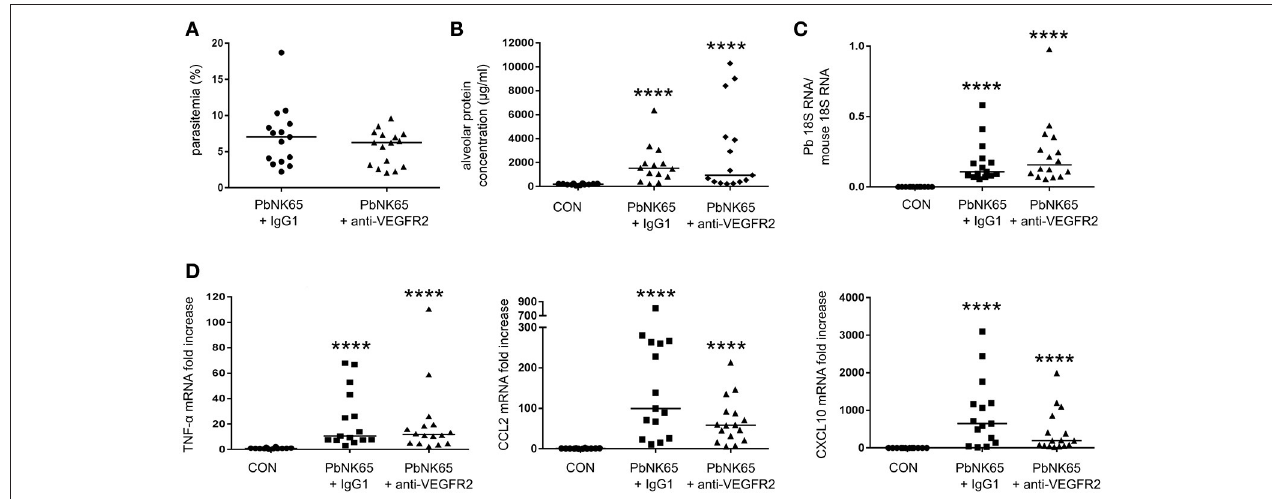
FIGURE 5 | Treatment of PbNK65-infected mice with anti-VEGFR-2 Ab does not decrease lung pathology. C57BL/6 mice were infected with PbNK65 and were treated by IP injection of the VEGFR-2-neutralizing antibody clone DC101 (anti-VEGFR-2) or with an isotype control (IgG1a) at day 6 pi. (A) Peripheral parasitemia at day 8 pi is shown and (B) alveolar edema was measured by protein determination in BALF samples. (C,D) The mRNA expression of P. berghei 18S, TNF- α , CCL2, and CXCL10 was analyzed by qRT-PCR. Compilation of three experiments, n = 12–16 per group.